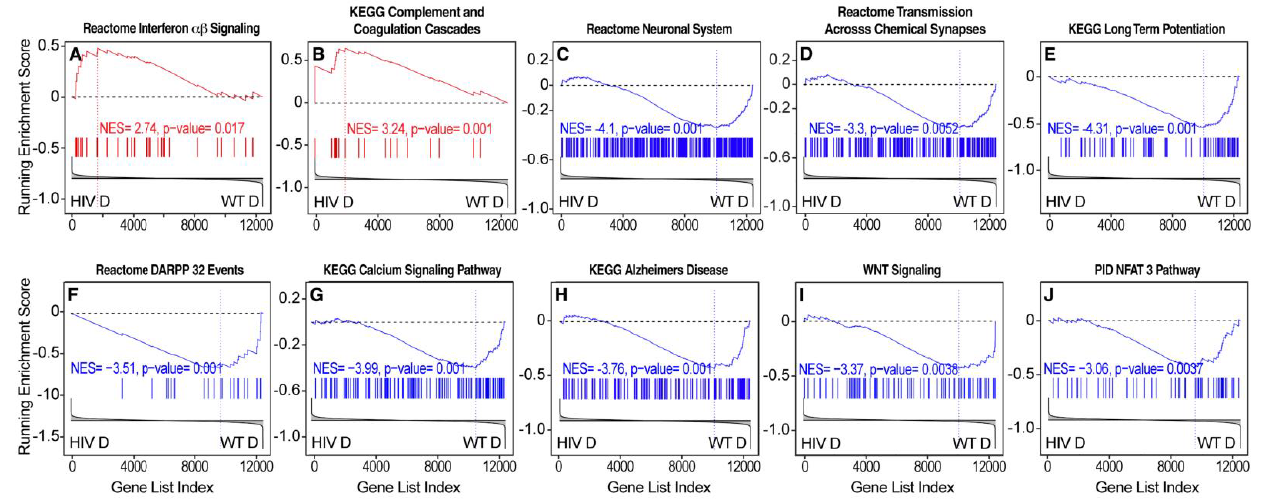
Figure 5. Transcriptional evidence of increases in neuronal injury and neurodegeneration in HIV Tg rats that self-administered oxycodone under dependent (LgA) conditions. Representative pathways that were differentially activated by GSEA are indicative of an increase in the expression of ( A ) interferon (IFN) signaling and ( B ) complement (which has been implicated in increases in inflammation and neurodegeneration [88]) and the broad downregulation of ( C ) neuronal genes, including genes that are involved in ( D ) neuronal communication, ( E ) neural plasticity, and ( F , G ) signaling and ( H ) genes that are involved in neurodegenerative conditions (e.g., Alzheimer’s disease) and ( I , J ) trophism. Each bar represents a gene in the gene set [60]. NES, normalized enrichment score [60]; HIV D, HIV Tg rats that self-administered oxycodone under dependent (long access (LgA)) conditions; WT D, wildtype rats that self-administered oxycodone under dependent conditions. NES = normalized enrichment score [60].